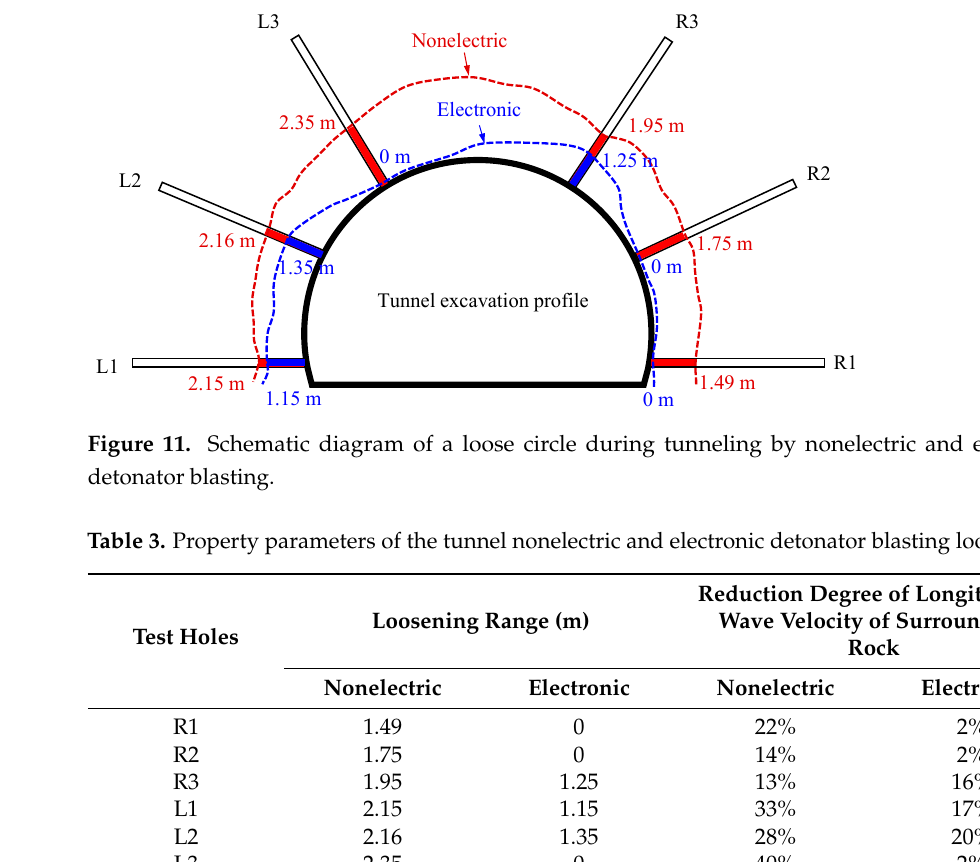
Figure 10. Variation in the longitudinal wave velocity of the surrounding rock with the test hole depth during tunnel electronic detonator blasting excavation. ( a ) R1, ( b ) R2, ( c ) R3, ( d ) L1, ( e ) L2, and ( f ) L3.